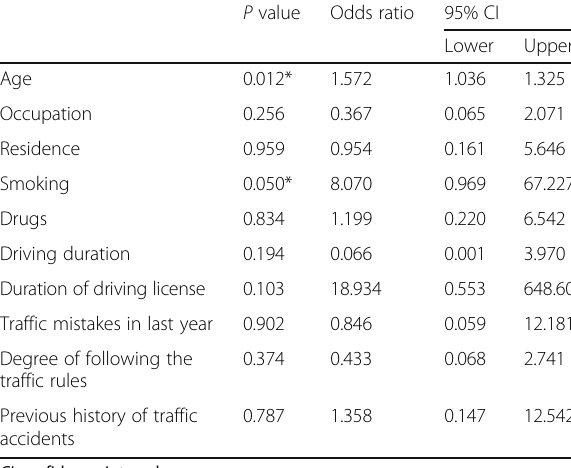
Table 5 Predicted risk factors for the development of MHE by multivariate logistic regression